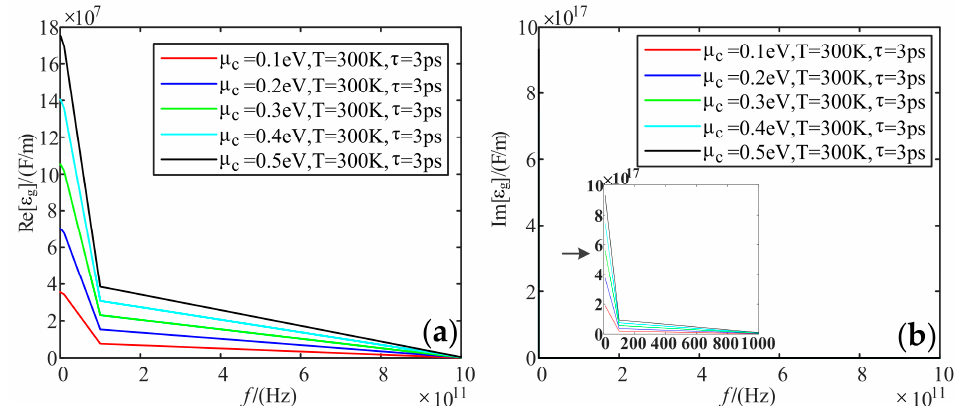
Figure 7. Variation curve of graphene dielectric constant with frequency at different electrochemical potentials: ( a ) real part; ( b ) imaginary part.